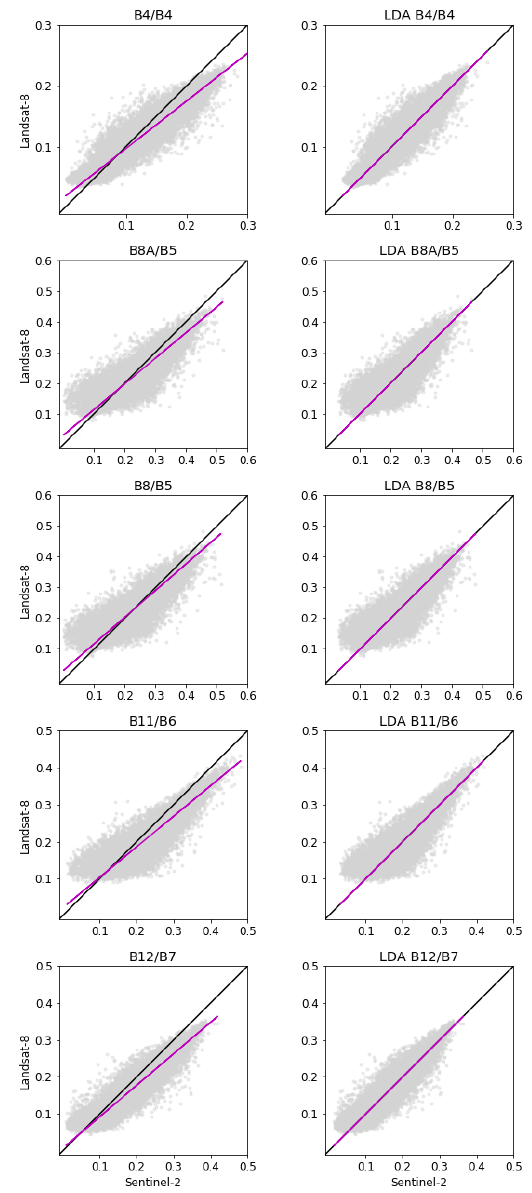
Figure 4. Comparison of surface reflectance values from the Sentinel-2 and Landsat-8 corresponding bands for the Lena Delta. Left plots: observed surface reflectance values. Right plots: Lena Delta Adjusted (LDA) Sentinel-2 reflectance values. The solid black line is one-to-one, and the pink line is the ordinary least squares regression trend line. In all plots, the Sentinel-2 values and bands are on the x -axis, while Landsat-8 is depicted on the y